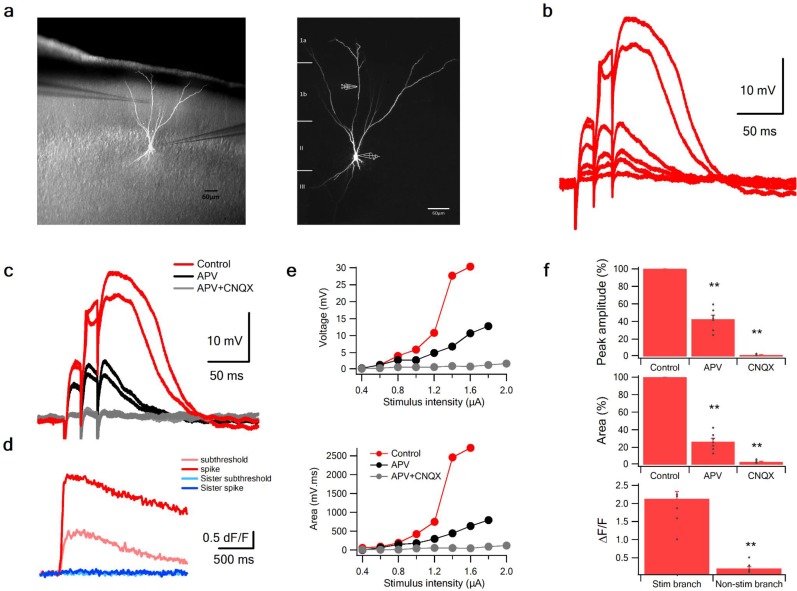
NMDA spikes in PCx pyramidal neurons: parasagittal slices.(a) Parasagittal PCx slice showing reconstructed layer two pyramidal neuron. Right, same neuron as shown with higher magnification, patch clamp recording electrode and stimulating electrodes (200 µm from soma) are illustrated. The pyramidal neuron was filled with intracellular solution containing high chloride concentration (20 mM) and calcium sensitive dye OGB-6F (200 µM). Calcium imaging was performed from the stimulated dendrite (red circle) and non-stimulated sister dendrite (blue circle). (b) Voltage responses evoked by gradually increasing synaptic stimulation consisting of a burst of 3 pulses at 50 Hz. (c) Spike was evoked in control conditions (red), which was blocked with the addition of the NMDAR blocker APV (50 µM, black). The residual EPSP was abolished with CNQX (10 µM, grey). (d) Calcium transients evoked at just threshold stimulation (ligh red and blue) and at threshold stimulation for NMDA spike (red and blue) at the stimulated dendrite (red) and sister dendrite (blue). **p < 0.01 (e). Current voltage (upper panel) and area (bottom panel) relationship in control (red), APV (black) and CNQX (grey). (f). Summary plot mean (±SEM) for spike peak amplitude (upper panel) and area (middle panel) in control (n = 10), after APV application (n = 7) and CNQX (n = 6). Lower panel peak calcium transients (ΔF/F) in the stimulated and non-stimulated dendritic branches (n = 8). ANOVA test for comparison of all three groups (control, APV and CNQX) showed statistical significance (p < 0.01). **p < 0.01 for post-hoc analysis (Dunnett test) comparing each of the two groups (APV and CNQX) to the control yielded a significant difference (p < 0.01). In addition, comparison of the CNQX and APV groups using the post-hoc Tuckey-Kramer test also yielded p < 0.01.